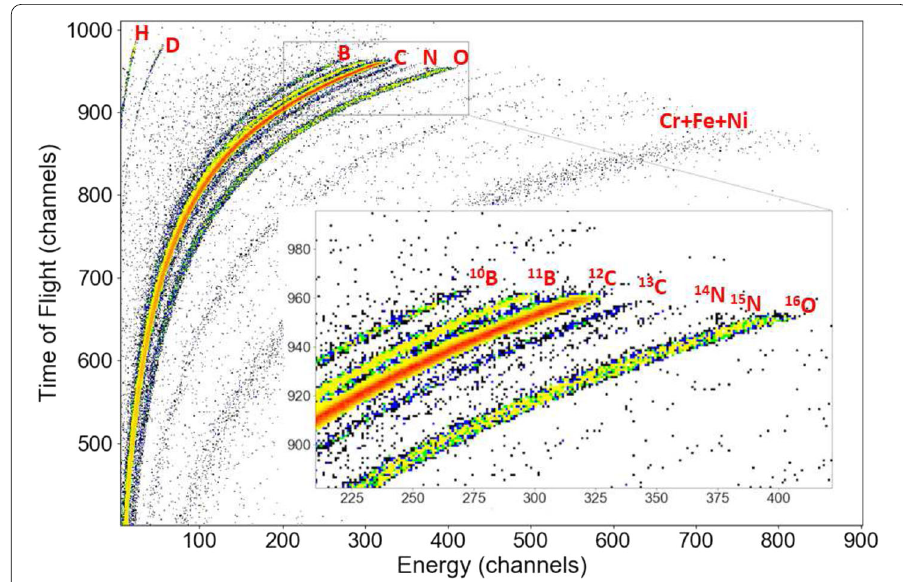
Figure 2 ToF HIERDA spectrum recorded after tracer experiments for the limiter tile of TEXTOR